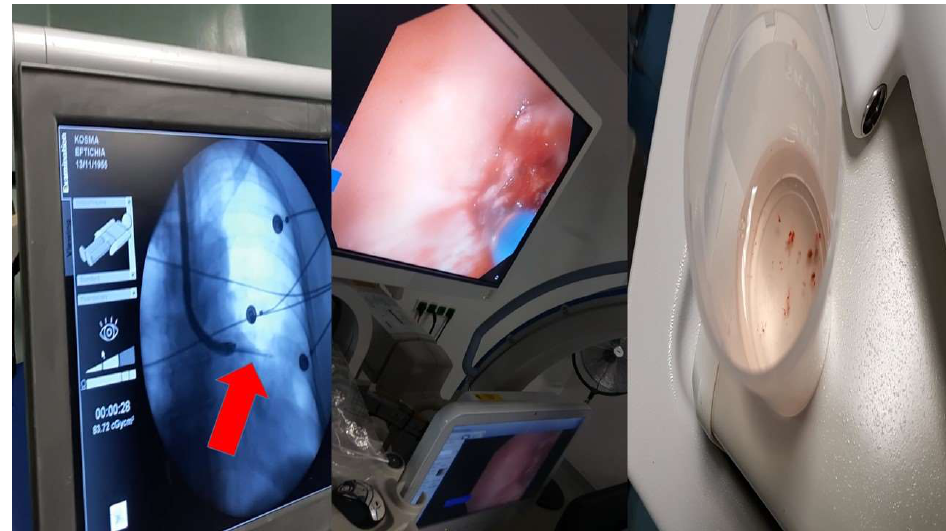
Figure 3. Left: C-Arm with the forceps outside the working channel of the bronchoscope during biopsy; middle: image during biopsy; and right: sample specimen.